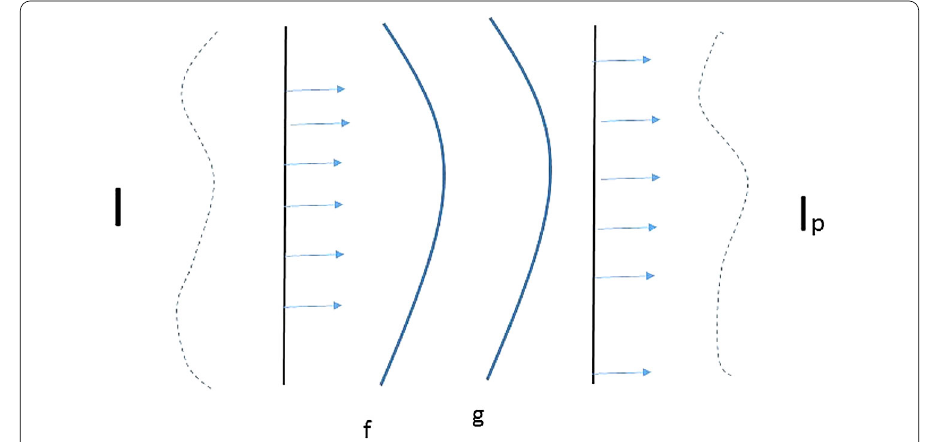
Figure 1 Shaping arbitrary collimated